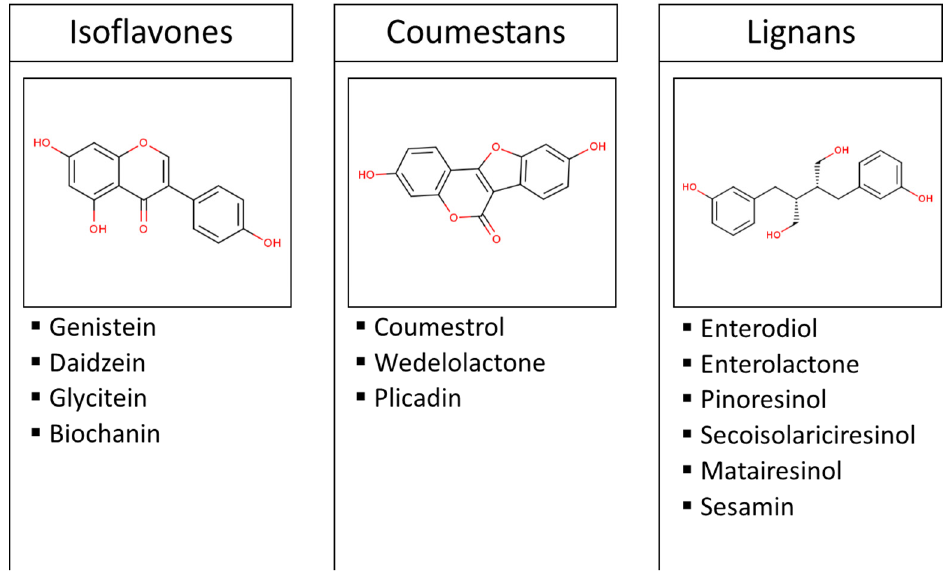
Figure 1. Classification and examples of the most common dietary phytoestrogens. Images are the chemical structures of genistein, coumestrol, and enterodiol.